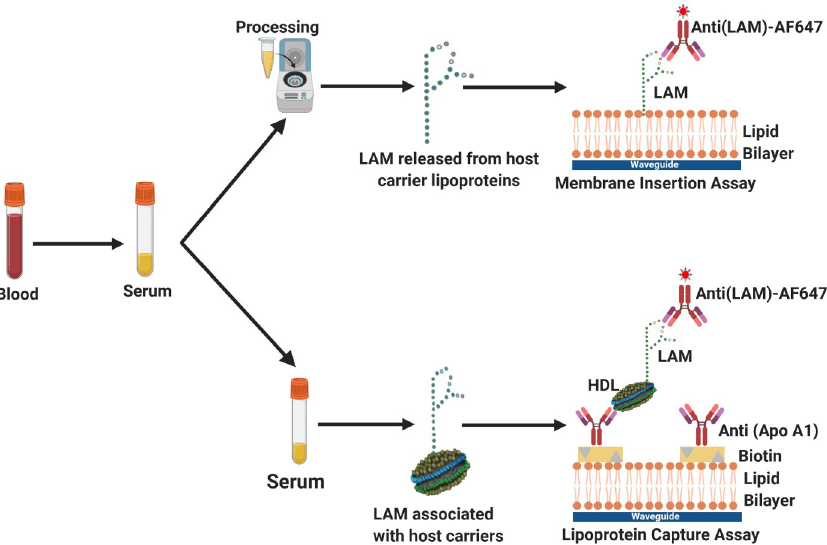
Fig 1. Overview of lipoarabinomannan (LAM) detection strategies. When LAM is associated with a host lipoprotein carrier such as HDL, detection can be performed using lipoprotein capture, which requires two antibodies, as well as prior knowledge of LAM-lipoprotein carrier associations. An antibody targeting apolipoprotein A1, the coat protein of HDL, is used to capture the nanodiscs on the assay surface, followed by detection with a fluorescently labeled antibody targeting LAM. In the absence of sequestration by a host lipoprotein carrier, LAM can be directly detected by membrane insertion, which requires only one antibody. The amphiphilic antigen, LAM, is allowed to partition into a supported lipid bilayer interface, followed by detection with a specific fluorescently labeled antibody. Graphic representations are not drawn to scale. Figure created with BioRender.com.